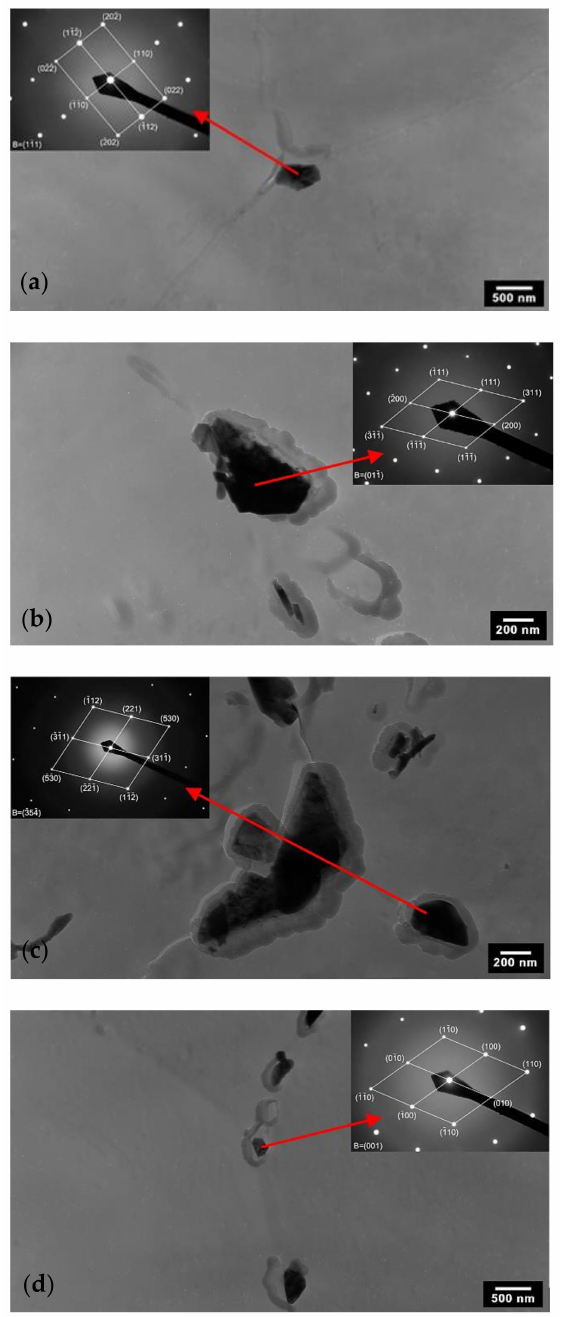
Figure 5. Secondary phases identified in AISI 316L (0% CW) with diffraction patterns corresponding to the marked particles (TEM of carbon extraction replicas): ( a ) chi phase in 650 ◦ C/10 h condi- tions; ( b ) M 23 C 6 carbide in 650 ◦ C/1000 h conditions; ( c ) sigma phase in 650 ◦ C/1000 h conditions; ( d ) Laves phase in 650 ◦ C/1000 h